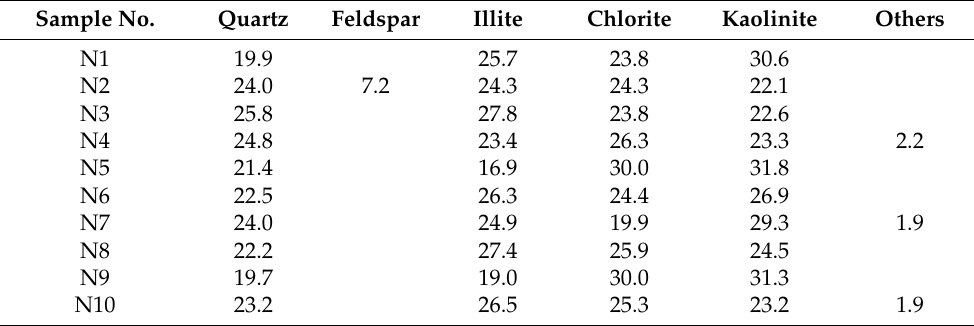
Table 1. The mineral information for natural soil (Nansha, Guangzhou, China). Sample No. Quartz